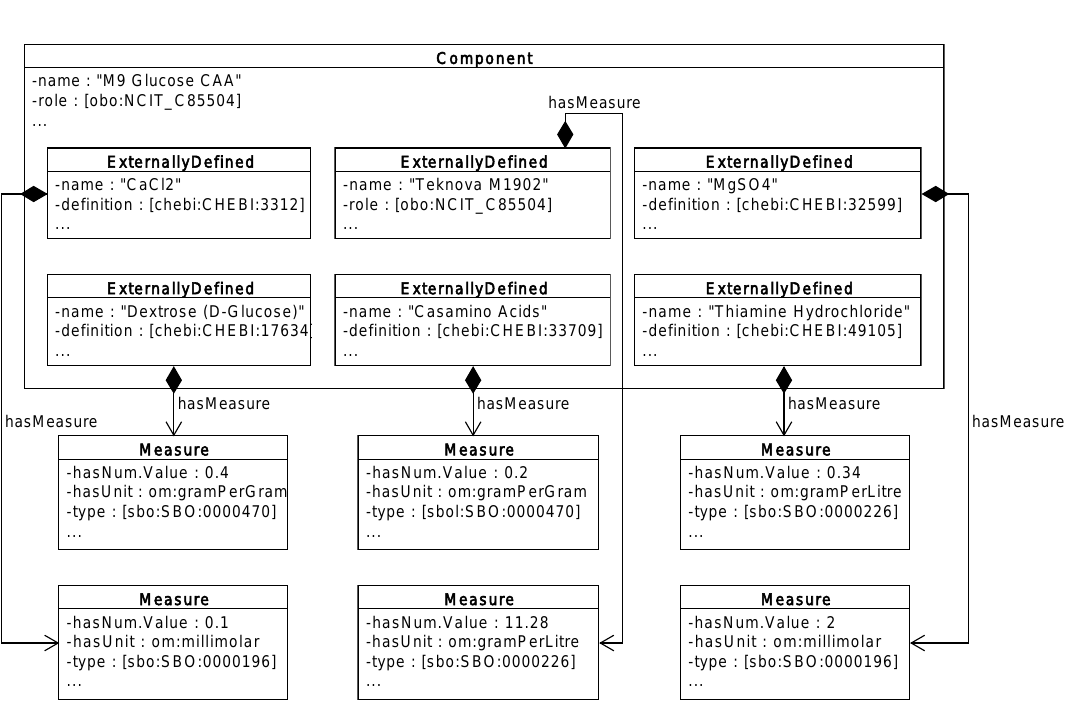
Figure 30: Growth media recipe represented using instances of the om:Measure and om:Unit classes from the